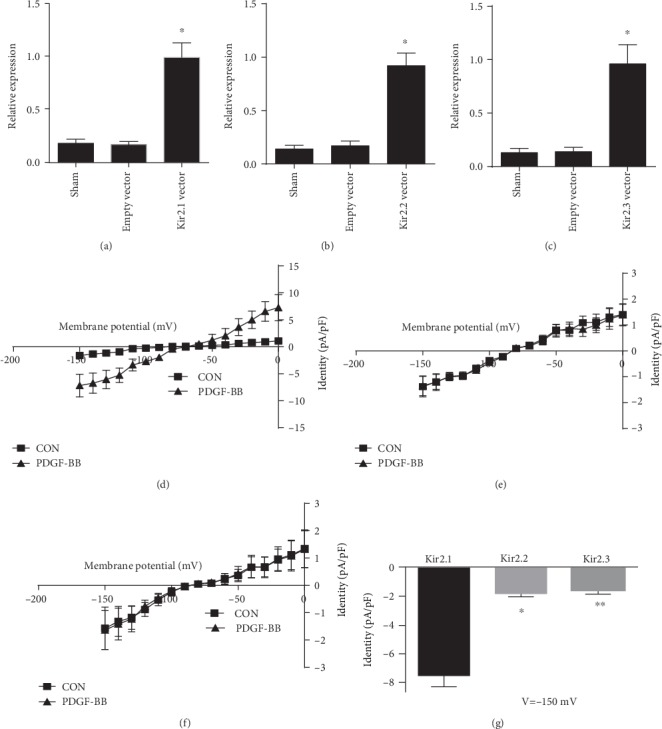
Effects of PDGF-BB on Kir2.1, Kir2.2, and Kir2.3 in transiently transfected HEK293 cells. (a–c) The transfections of the Kir2.1, Kir2.2, and Kir2.3 vector were verified by RT-PCR. (d–f) Arithmetic mean ± SEM (n = 10) of current-voltage relationship curves. (g) Arithmetic mean ± SEM (n = 10) of the current amplitude at -150 mV of Kir2.x currents in PDGF-BB; Kir2.1. ∗P < 0.05 vs. Kir2.2, Kir2.1; ∗∗P < 0.05 vs. Kir2.3. CON means vascular smooth muscle cells without any drug intervention.